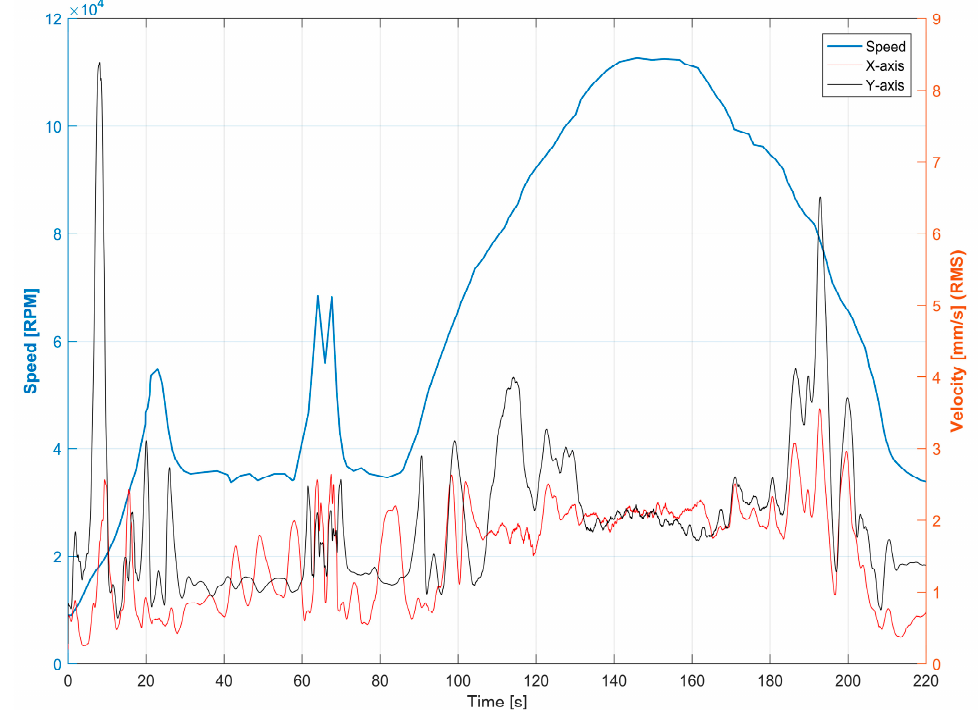
Figure 13. Vibration levels variation depending on the turbo engine speed.